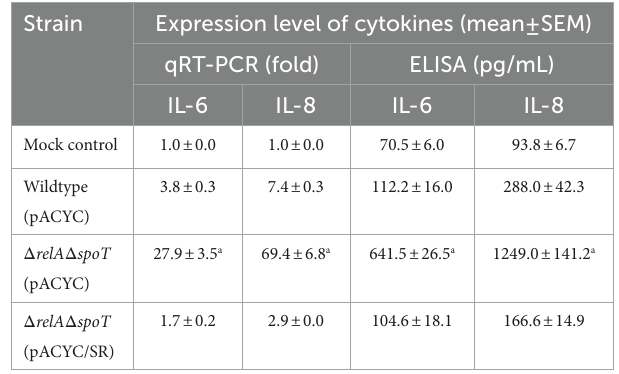
TABLE 4 Increased expression levels of IL-6 and IL-8 in 3D4/31 infected with Δ relA Δ spoT EPEC.